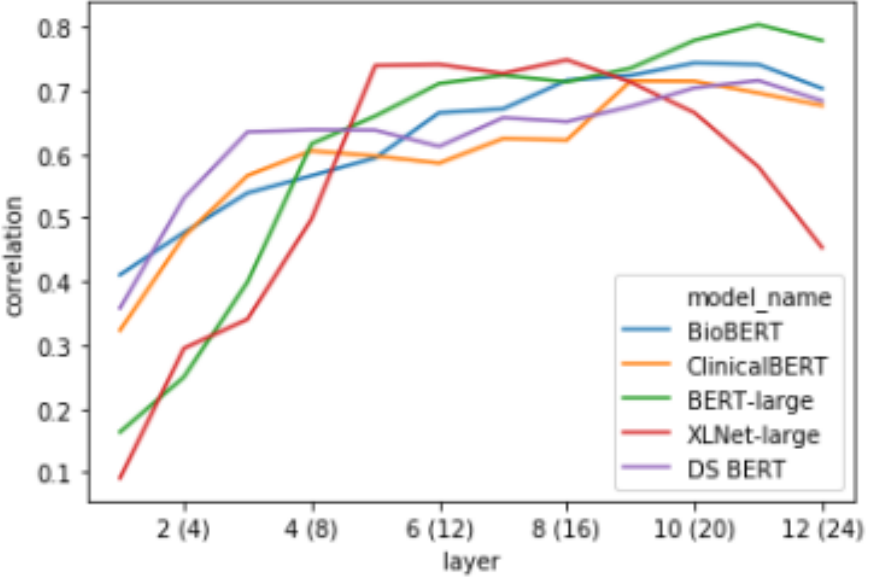
Representational Similarity